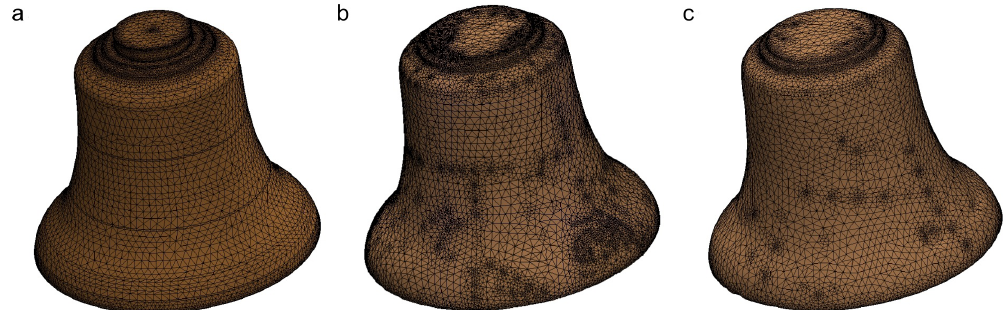
Figure 9. Generated meshes: ( a ) reference model; ( b ) scanned model CuSn20; ( c ) scanned model